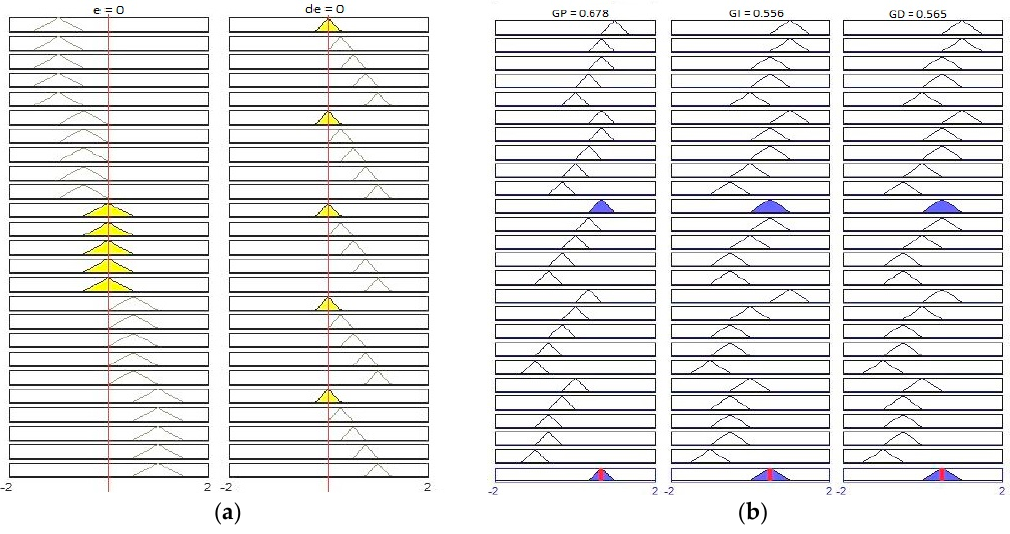
Figure 5. ( a ) Input rules for error and derivative error of the fuzzy-based Proportional Integral Derivative (PID) controller; ( b ) the output rules for the fuzzy-based PID controller.